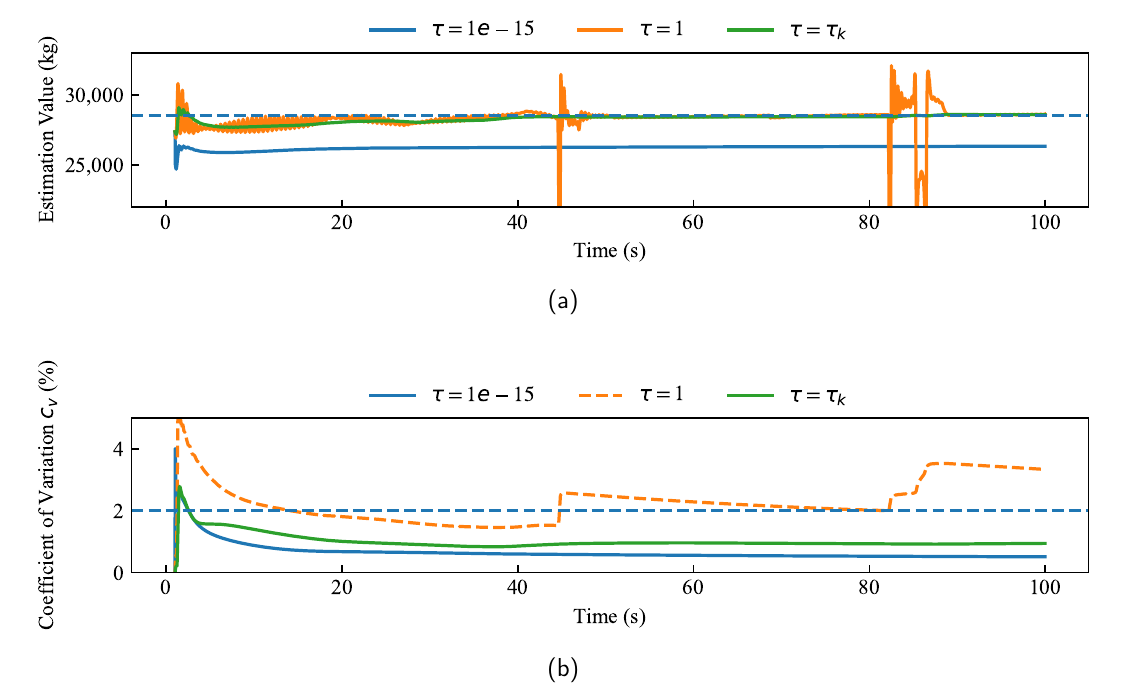
Figure 10. Simulation result of test 1 data using different values of weight to adjust: ( a ) Estimation value of mass. The blue dashed line represents the result of ground truth. ( b ) Evaluation with c v . The blue dashed line represents c v 0 = 2%.